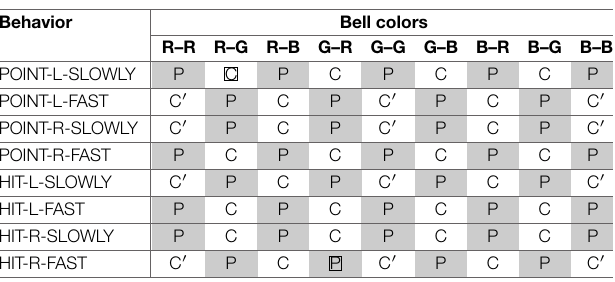
TABLE 1 | Episodes included in dataset 2 (72/144) .